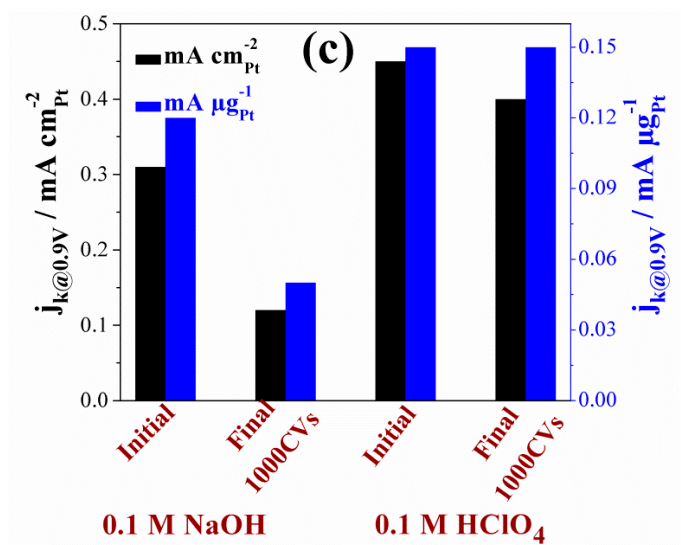
Figure 13. ( a ) Koutecky–Levich and ( b ) j k −1 plot for the determination of j L . Inset in (b) shows the Tafel plots: data are extracted from ORR after the durability test in 0.1